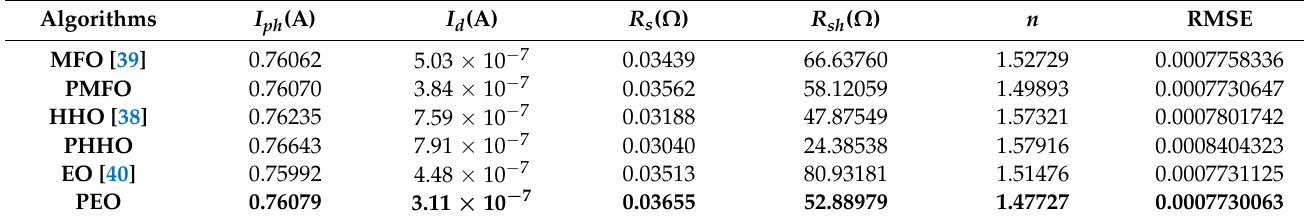
Table 3. Comparison under the extracted parameters and the corresponding RMSE of RTC France.